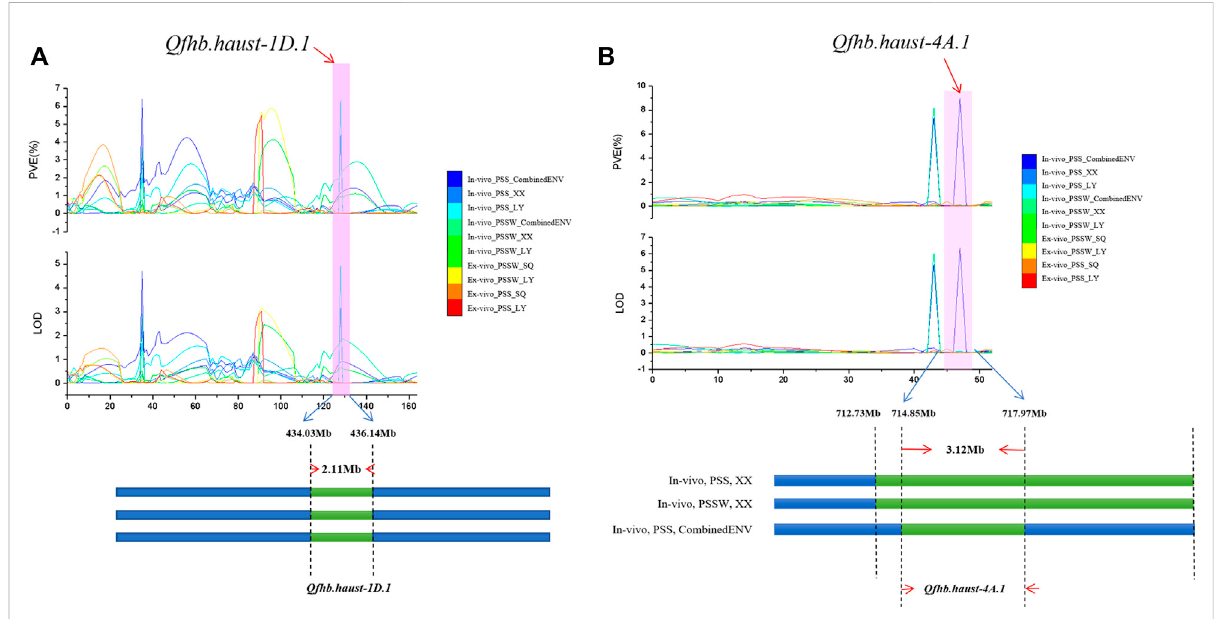
FIGURE 4 The LOD and PVE values of the whole linkage group 1D and 4A, the physical location and length of Qfhb. haust-1D.1 (A) and Qfhb. haust- 4A.1 (B) .